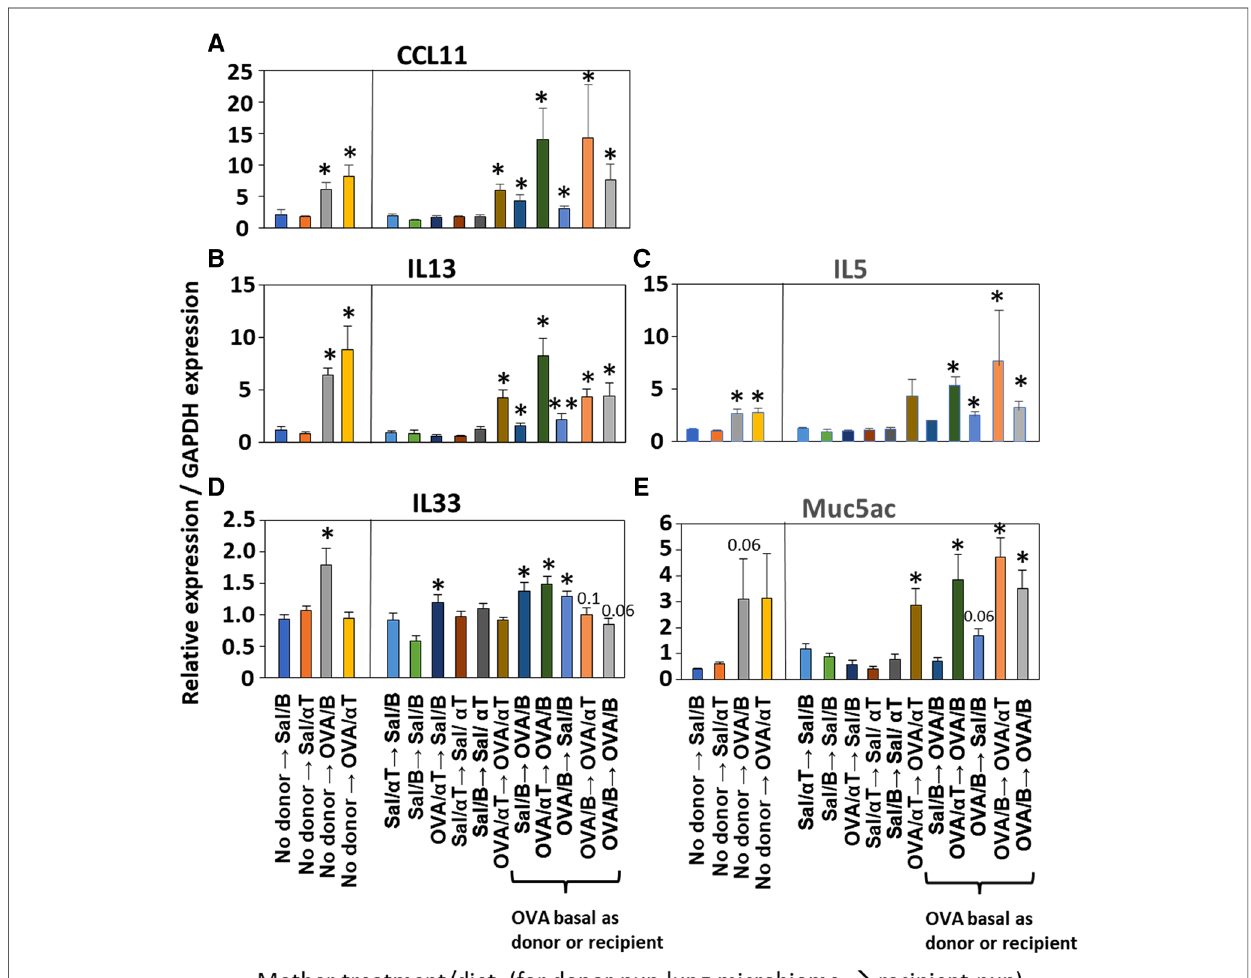
FIGURE 7 Recipient or donor microbiome from pups of allergic mothers (OVA,basal) conferred allergen-induced increases in CCL11, IL-13, IL-5, IL-33, and Muc5ac (red box). Mice were treated as in timeline in ( Figure 4A ). Lung cytokine expression was determined by qPCR. ( A ) CCL11. ( B ) IL-13. ( C ) IL-5. ( D ) IL-33. ( E ) Muc5ac. N =6 – 9/group. Data are presented as mean±SEM. N =6 – 9/group. Sal/B, saline-treated mother with basal diet. Sal/ α T, saline-treated mother with α T-supplemented diet. OVA/B, OVA allergen-treated mother with a basal diet. OVA/ α T, OVA allergen-treated mother with α T- supplemented diet. * p <0.05 as compared to the saline,basal → saline,basal group. ** p <0.05 as compared to saline/ α T → saline/ α T